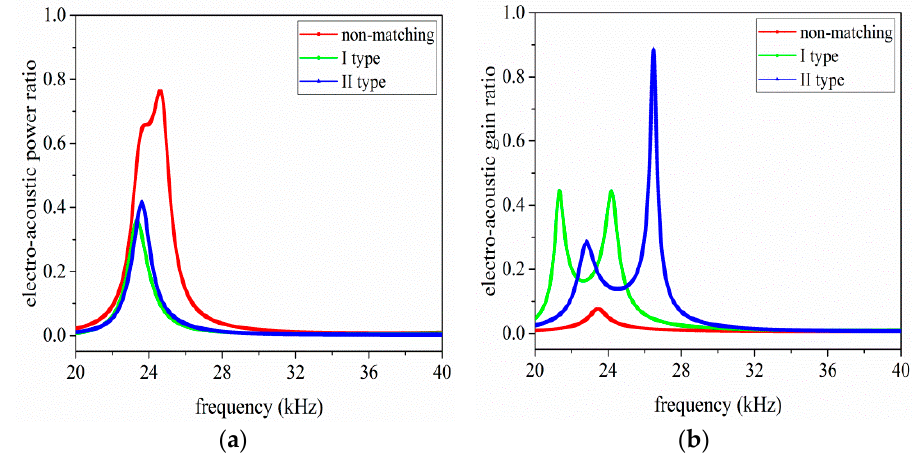
Figure 9. The electro-acoustic characteristics of the single sandwiched piezoelectric ultrasonic transducer with EIM network, ( a ) electro-acoustic power ratio, and ( b ) electro-acoustic gain ratio.